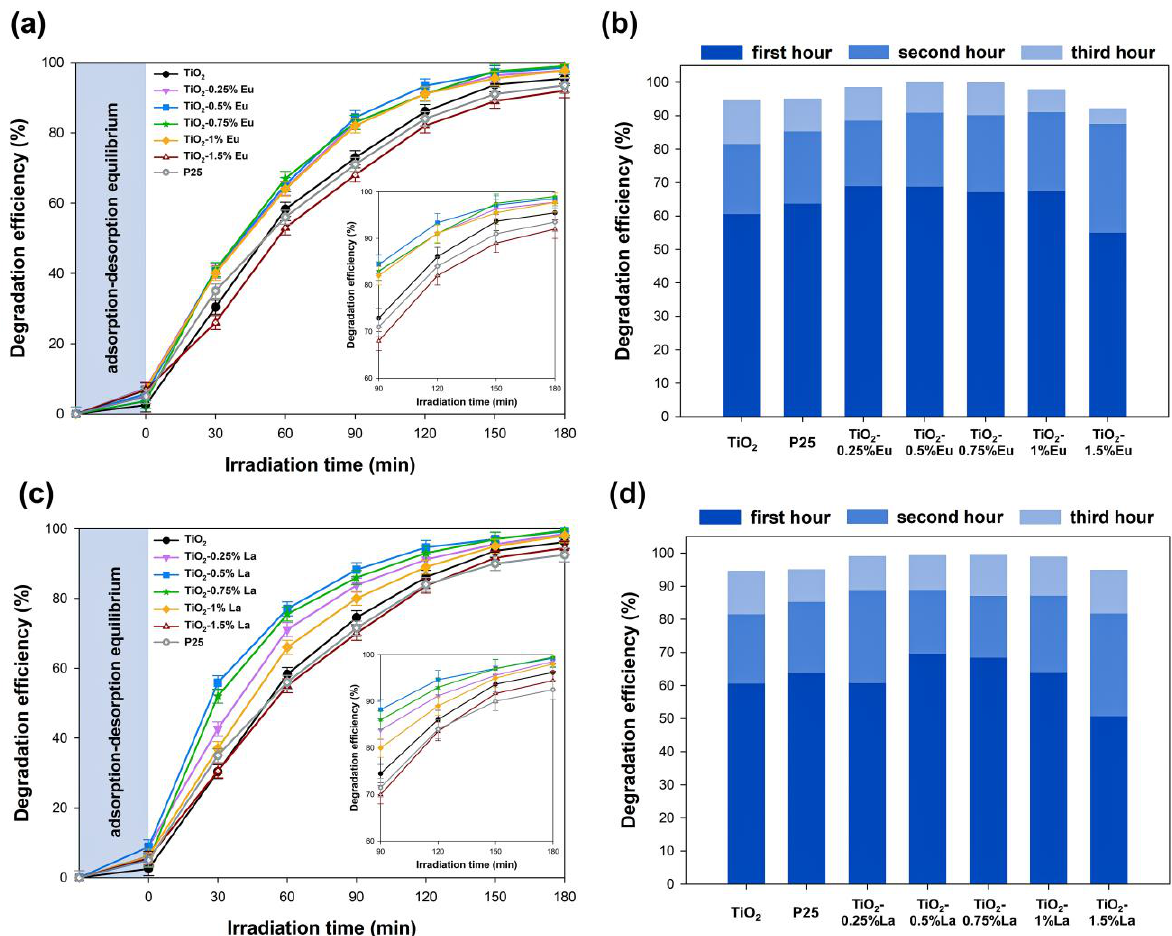
Figure 11. The results of degradation of metronidazole for TiO 2 -Eu ( a , b ) and TiO 2 -La ( c , d ) systems. The photodegradation curves ( a , c ) were made based on the UV-Vis data, while the loss after successive hours of irradiation ( b , d ) was determined by the HPLC technique.